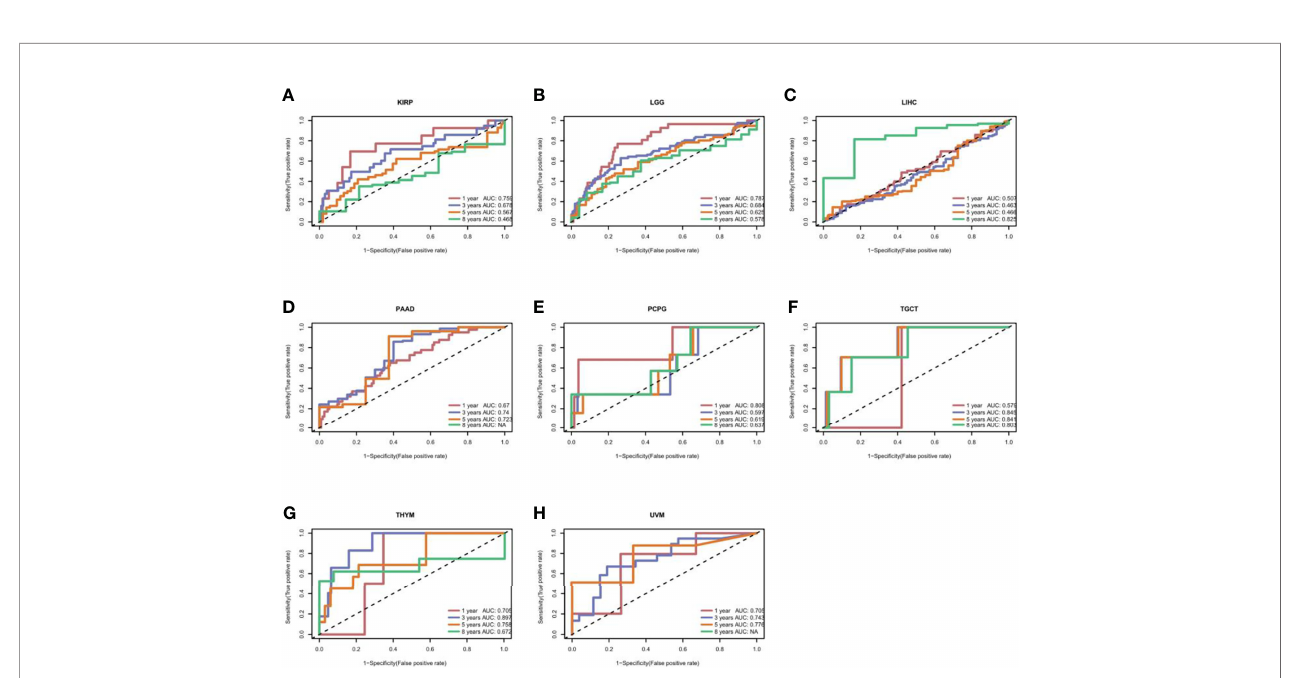
FIGURE 7 | The time-dependent receiver operating characteristic (ROC) curves for KIRP (A) , LGG (B) , LIHC (C) , PAAD (D) , PCPG (E) , TGCT (F) , THYM (G) , and UVM (H) . Area under the curve (AUC) scores in evaluating 1-, 3-, 5-, and 8-year OS are also shown in the fi gures.